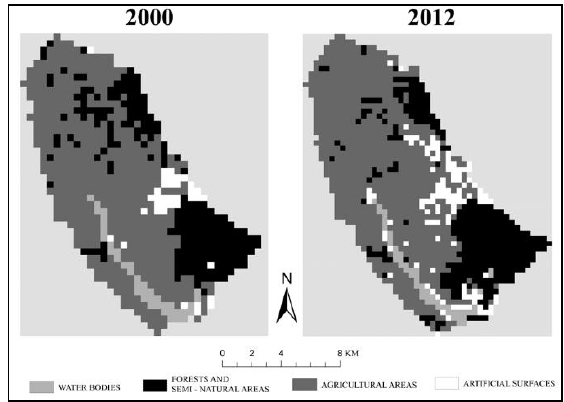
Figure 5. Generalized results